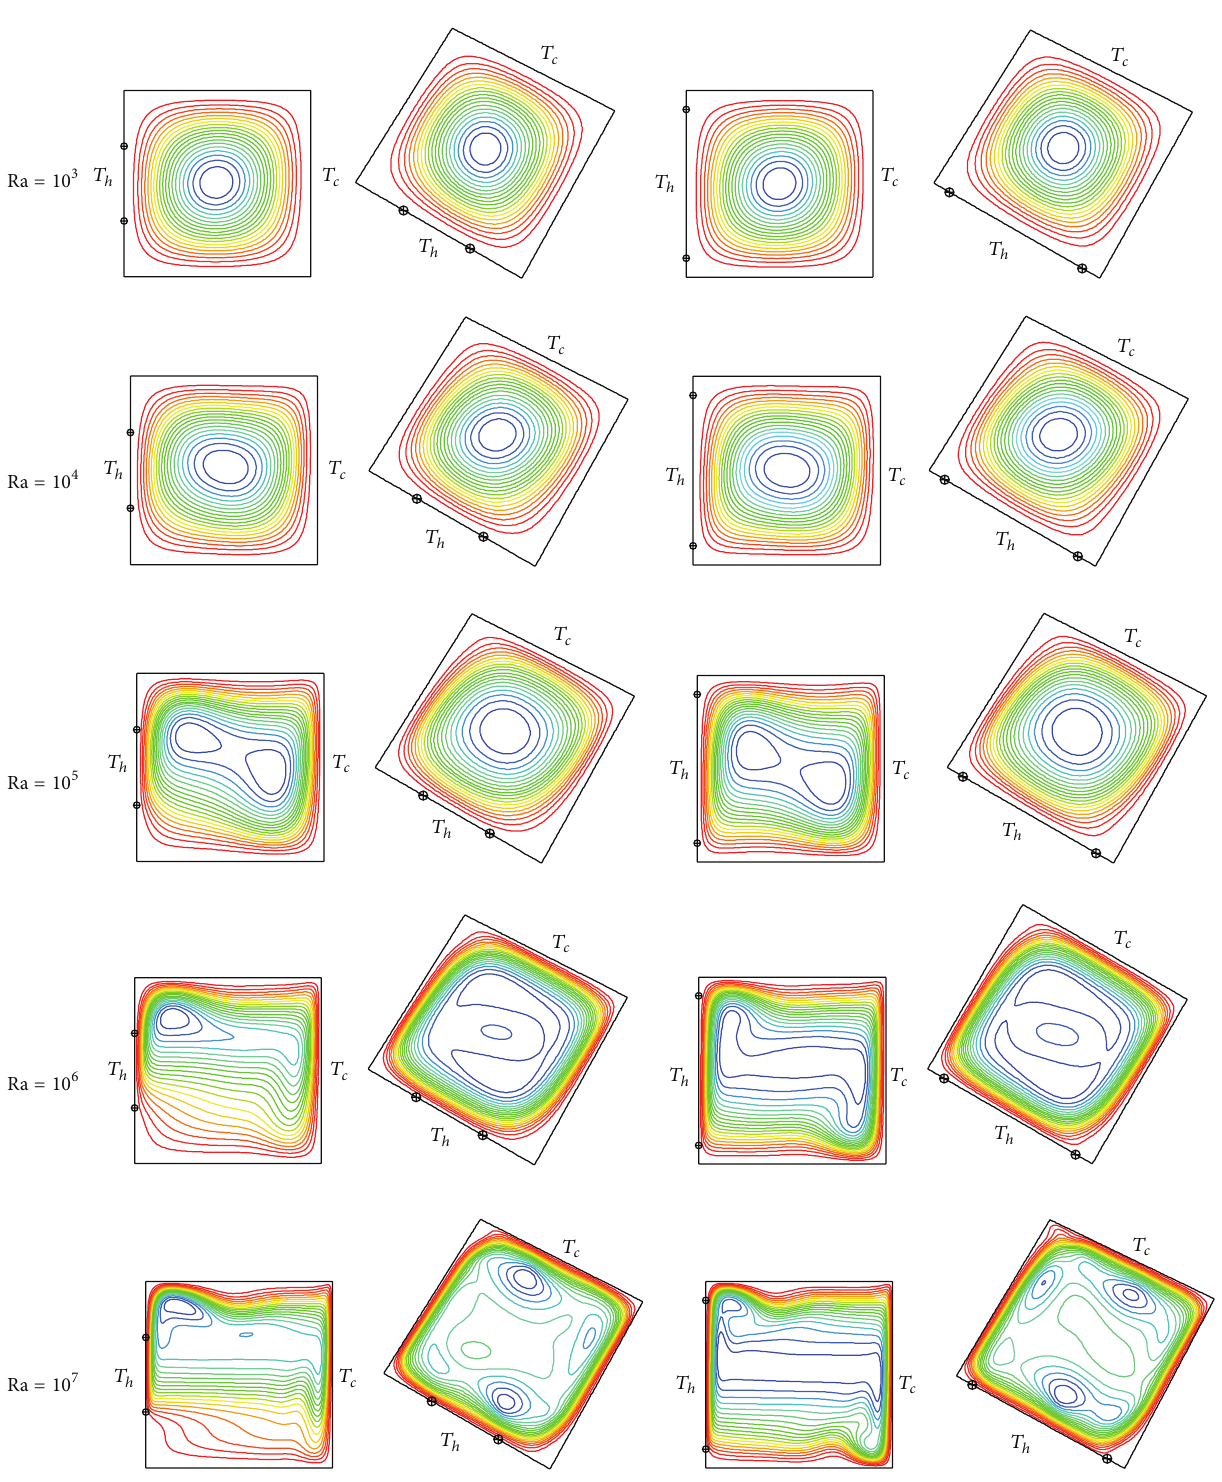
Figure 5: Streamlines for 𝐴 = 0.4 and 0.8 and 𝜃 = 0 ∘ and 60 ∘